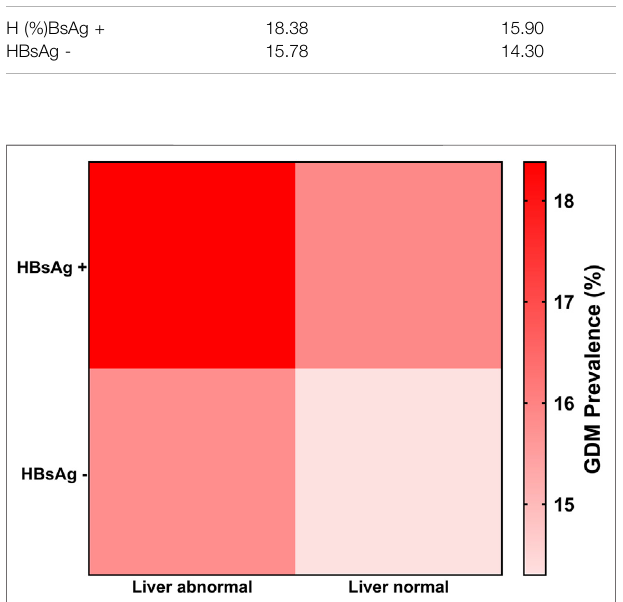
FIGURE 2 | GDM prevalence in live function normal and abnormal groups.